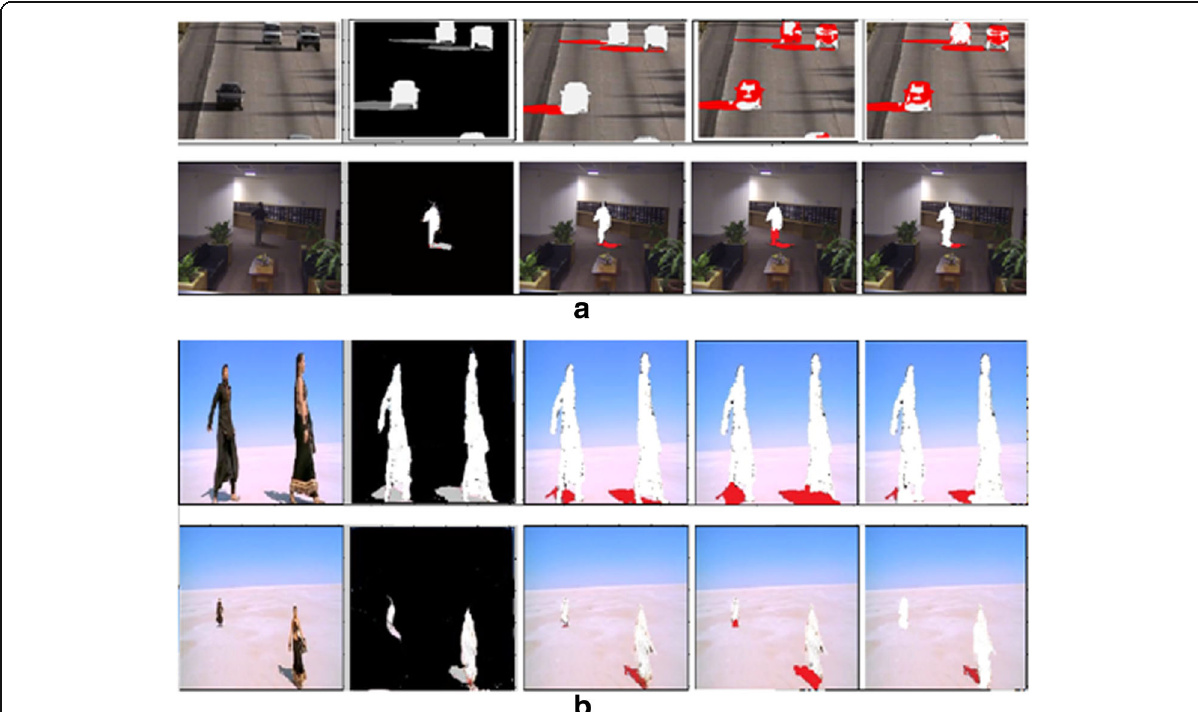
Fig. 7 Visualized comparison results of the proposed method with the state-of-art-methods. The first frame is the input, second is the ground truth, third is the proposed method result, fourth is the Guan [26] method result and fifth is the Khare et al. [27] method result. a Highway I video sequence and Lobby Hall video sequence. b “ Sarvam ” regional movie song — long and short